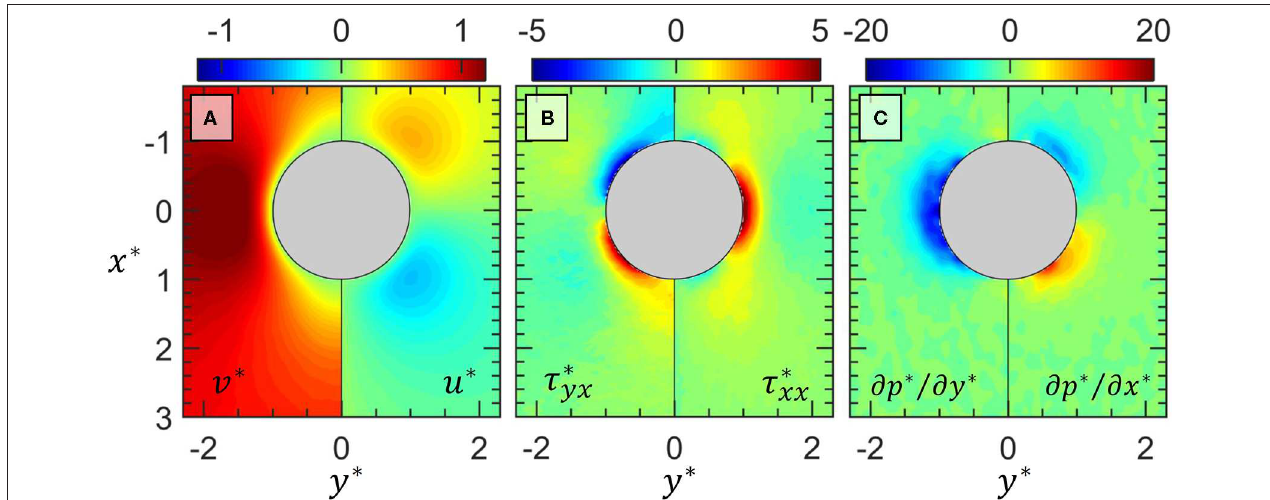
FIGURE 3 | The measured flow field around the oil drop (gray circle) prior to attachment of any bacteria. In (A) the y -component (left half) and x -component (right half) of velocity is shown. In (B) the shear (left half) and normal (right half) viscous stresses are shown. In (C) the y -component (left half) and x -component of the pressure gradients are shown. All quantities are normalized as described in the text. The magnitudes correspond to the respective color bar above each plot.